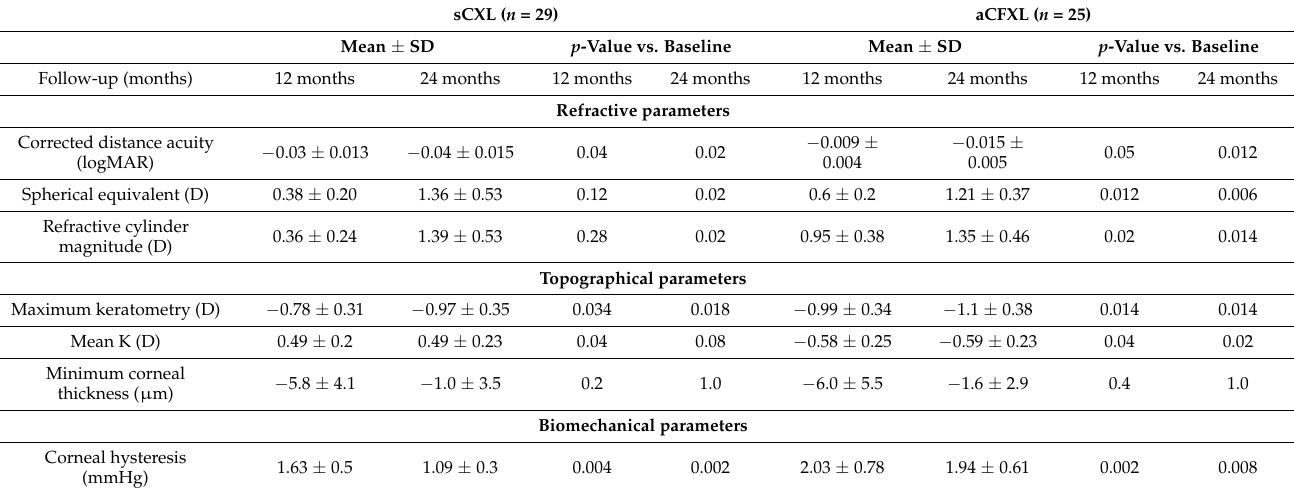
Table 3. Mean changes (postoperative values–preoperative values) of clinical outcomes in sCXL and aCFXL groups ( n = studied